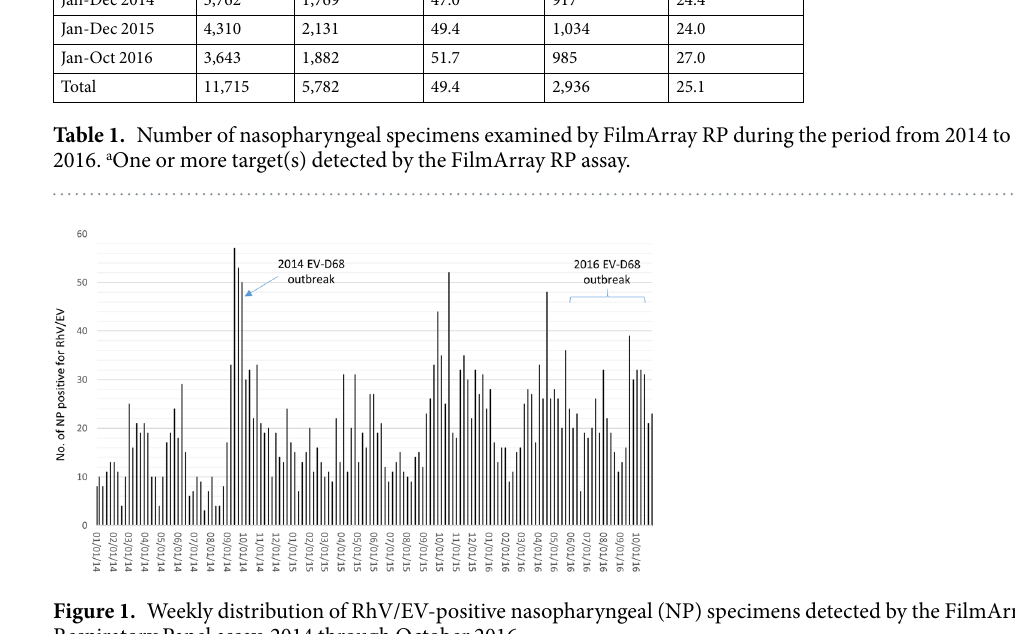
Figure 1. Weekly distribution of RhV/EV-positive nasopharyngeal (NP) specimens detected by the FilmArray Respiratory Panel assay, 2014 through October